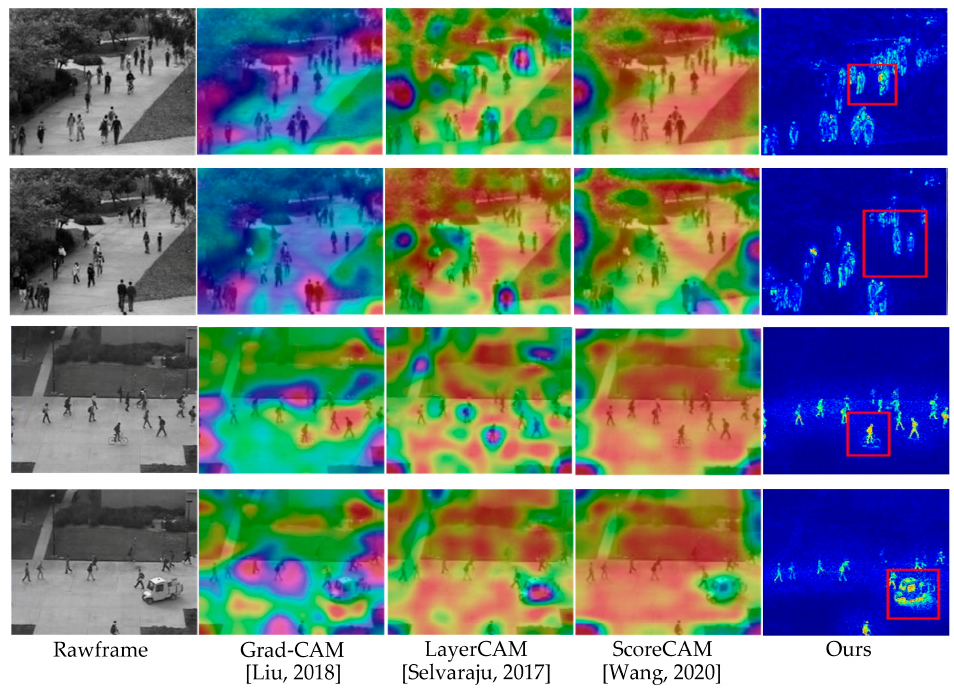
Figure 6 Figure 6. Comparison with other saliency methods on the Ped1 dataset. From left to right: original abnormal video frame, Gradient-CAM saliency [7], LayerCAM saliency [44], Score-CAM saliency [48], and our method. The bounding box explains the strange objects learned by the